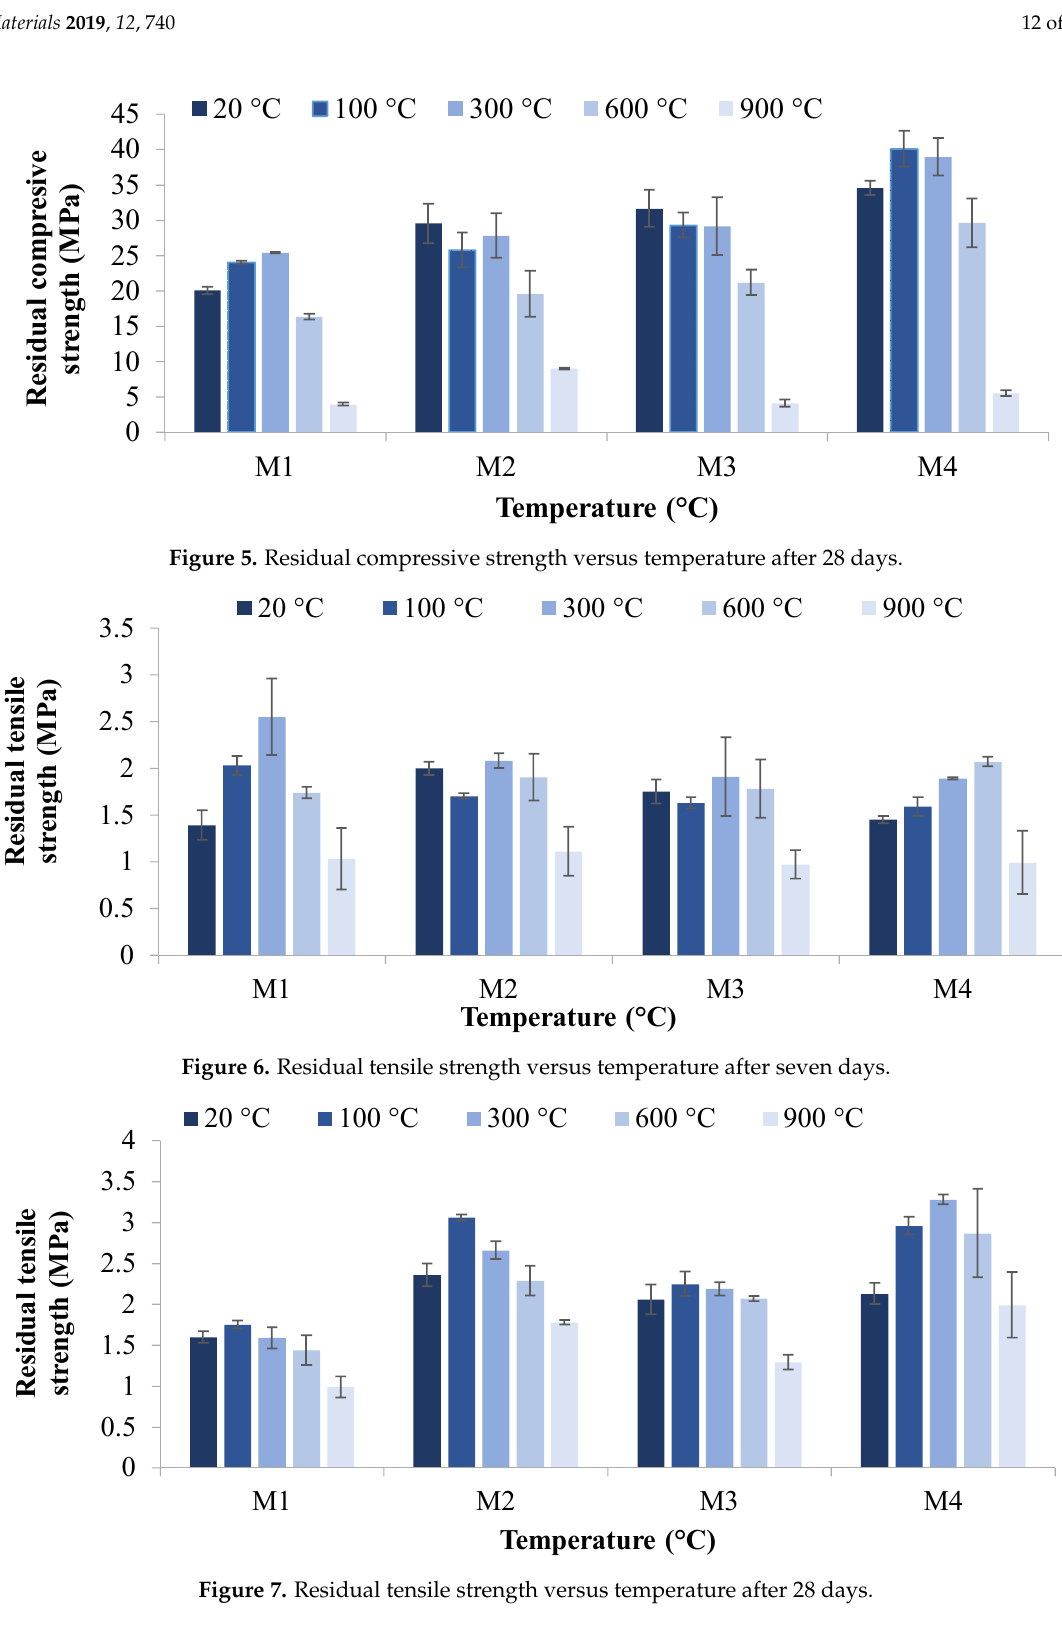
Figure 7. Residual tensile strength versus temperature after 28 days.